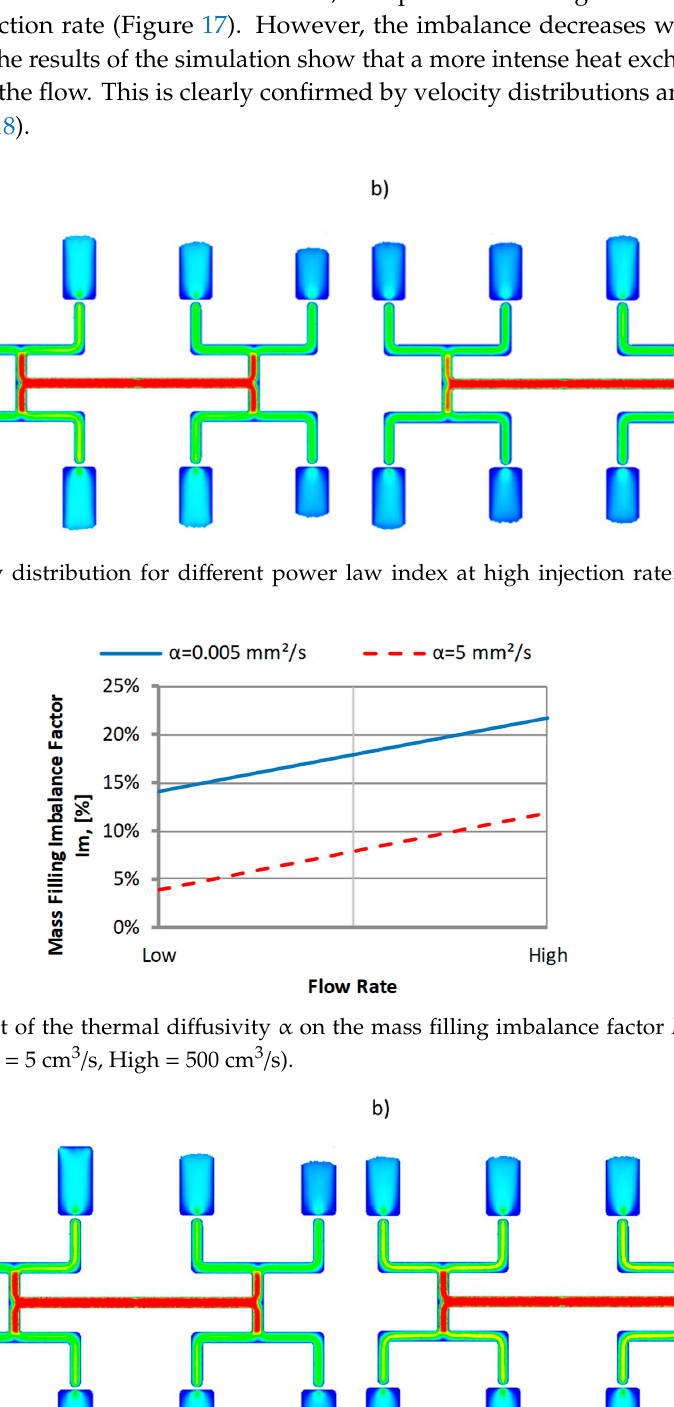
Figure 18. Velocity distribution for different thermal diffusivity at high injection rate: ( a ) α = 0.005 mm 2 /s, and ( b ) α = 5 mm 2 /s.